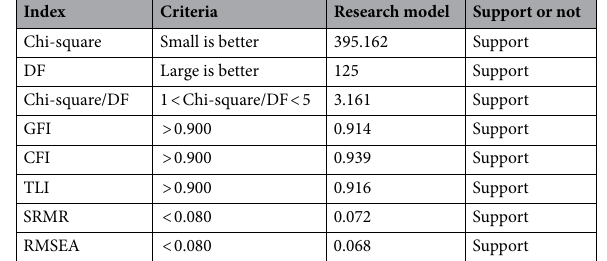
Table 5. Fit indices of the overall research model. DF degrees of freedom, GFI goodness-of-fit index, CFI comparative fit index, TLI Tucker-Lewis index, SRMR standardized root mean square residual, RMSEA root mean squared error of